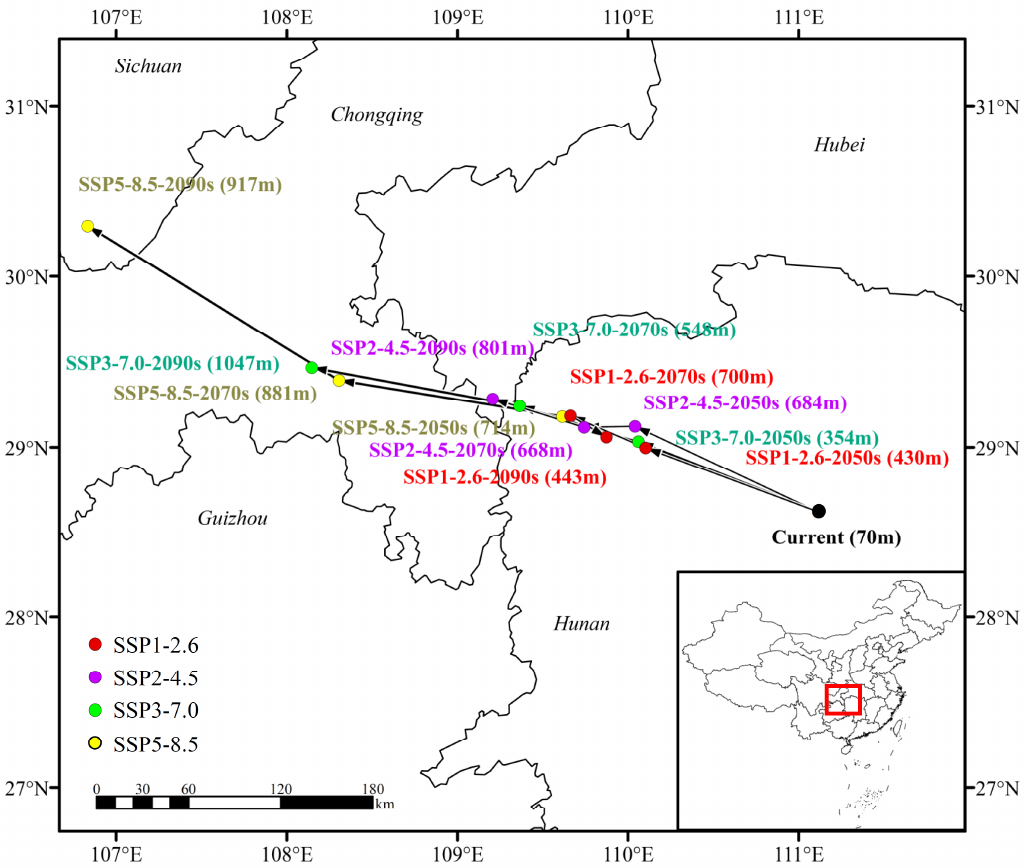
Figure 7. Core distribution shifts under 12 climate scenarios/years. Arrows indicate the magnitude and direction of predicted change over time.